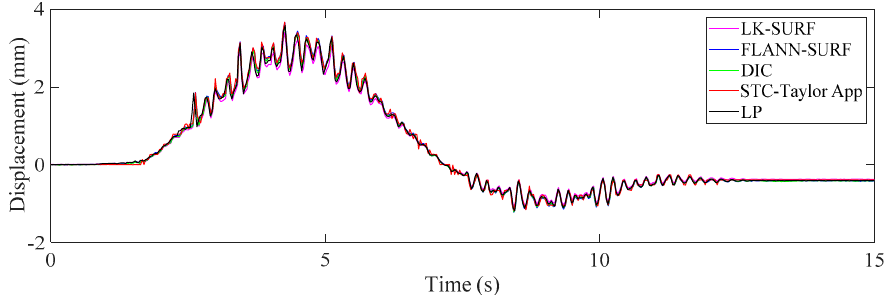
Figure 12. Case 1 (ideal condition): displacement time histories of P1 obtained from different methods.